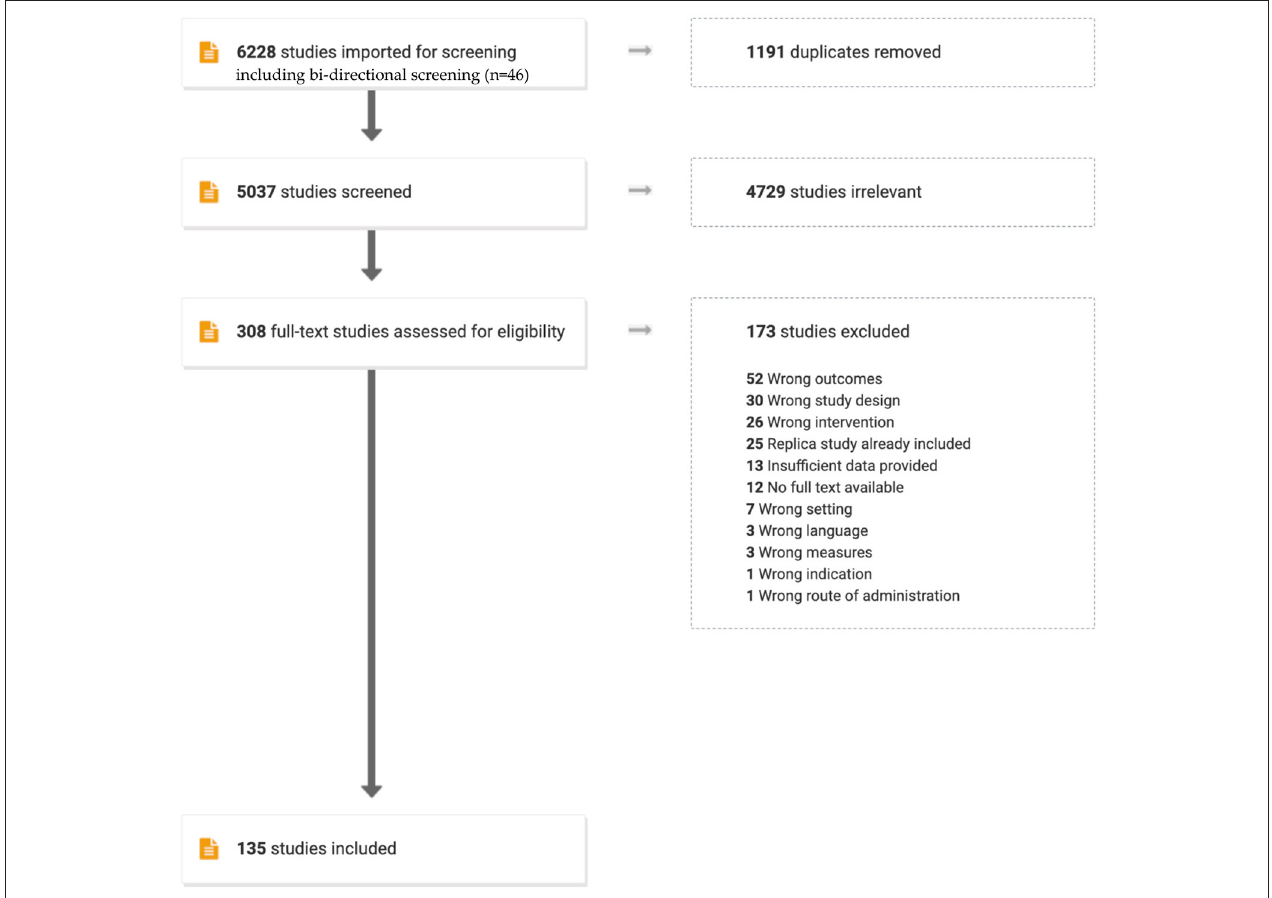
FIGURE 1 | Flowchart of study